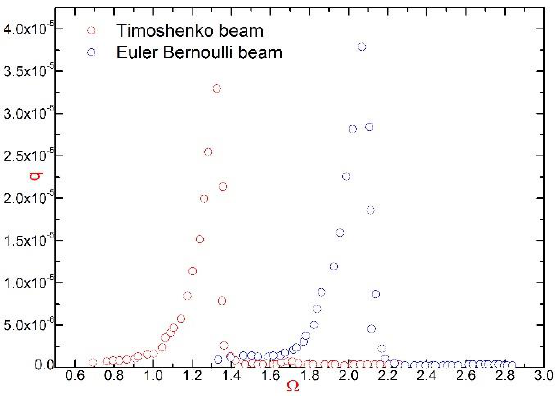
Figure 12. Comparison between Timoshenko beam and Euler Bernoulli beam in 1st order generalized coodinate of the frequency response curve.